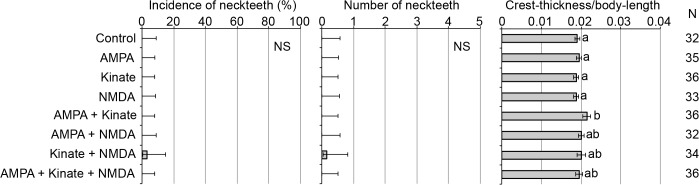
Effect of ionotropic glutamate receptor agonists on the three different indicators of the defensive morph.The indicators are incidence of neckteeth (left), average number of neckteeth (center), and crest thickness normalized to body-length (right). The final concentration of all chemicals used in this experiment was 10 μM. Error bars indicate 95% confidence intervals. Different letters indicate significant differences (p < 0.01). N: number of specimens.